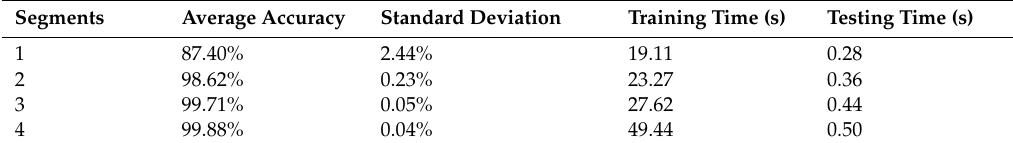
Figure 17. Diagnosis performance with di ff erent segments from 1 to 4. Table 5. Diagnosis accuracy and time consuming for di ff erent segments.